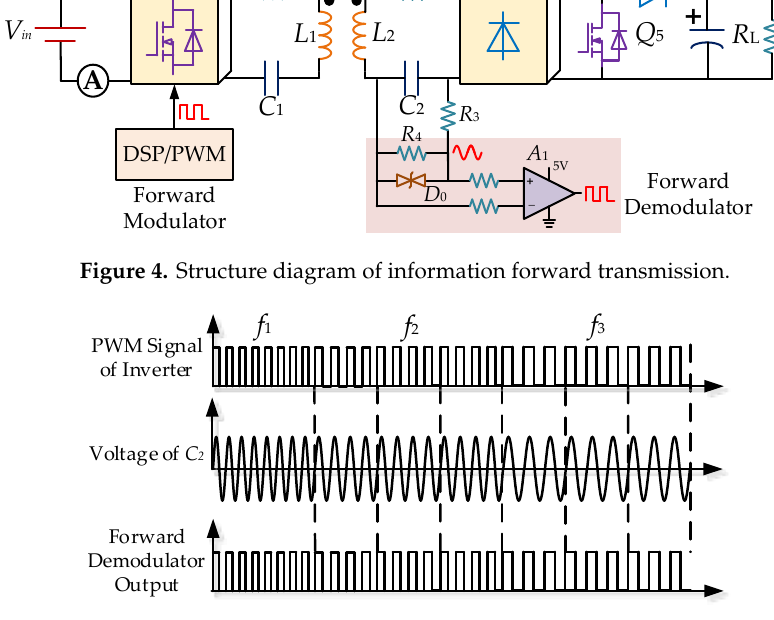
Figure 5. Voltage waveforms of di ff erent power frequencies.